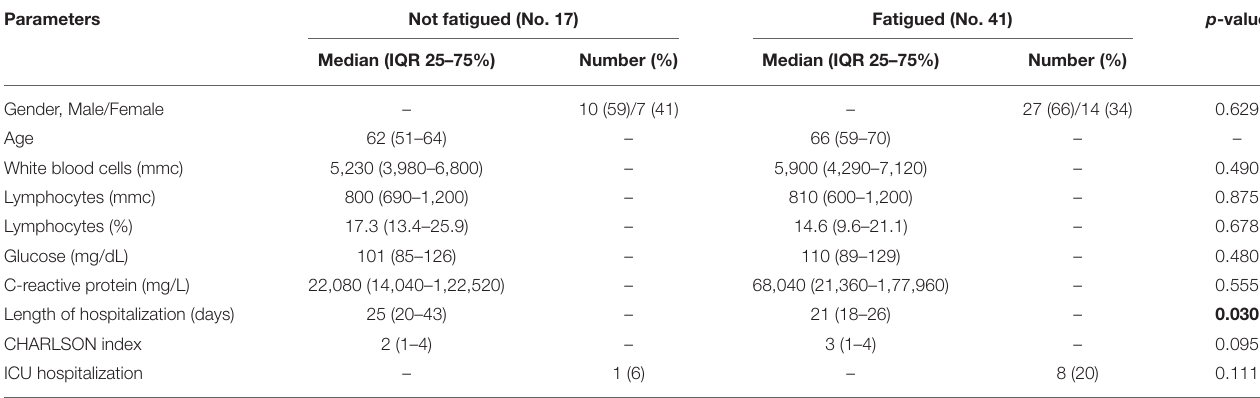
TABLE 3 | Demographic and clinical characteristic of fatigued and not fatigued SARS-CoV-2-infected